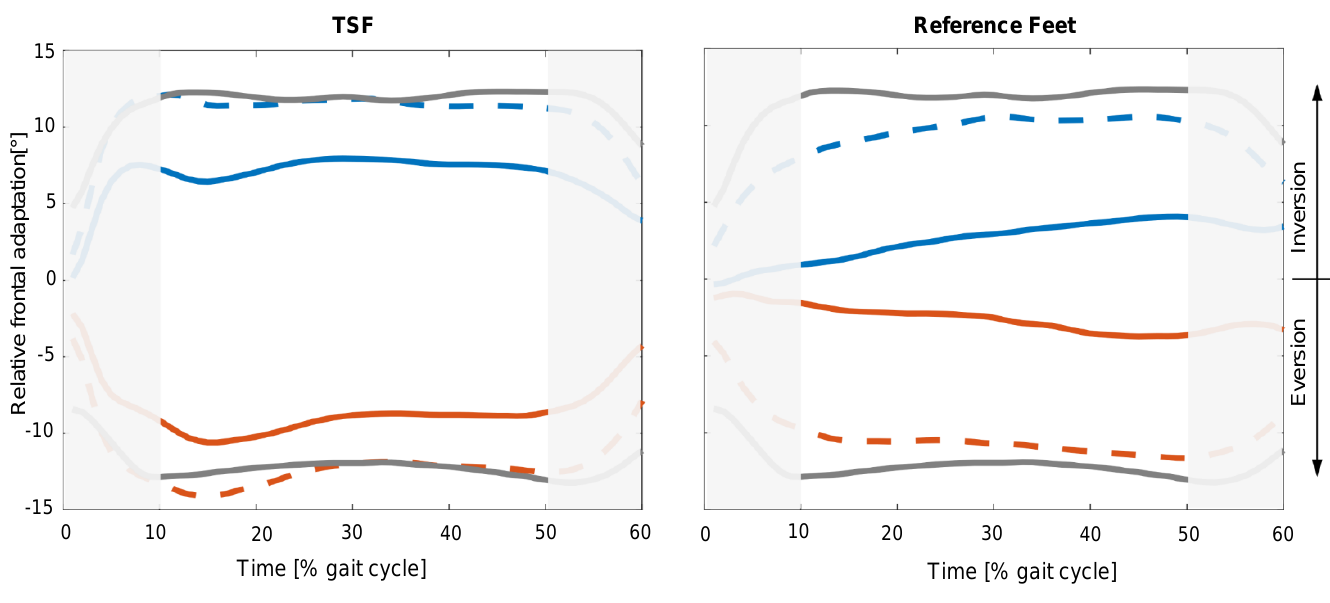
Figure 3: Relative frontal adaptation on the cross-slope for Triton Side Flex (left) and reference feet (right) for 10% to 50% GC (main loading interval). The solid red (hillside) and solid blue (valleyside) curves show the adaptation of the prosthesis via the antenna markers ( α base ). The grey (control subjects) and dashed (prosthetic side) curves show the adaptation determined by the markers on the shoes ( β sho e